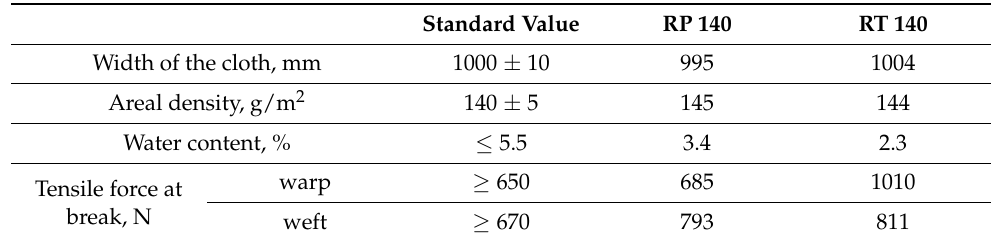
Table 3. It was obtained from Hunan Huashengdongting Ramie Co., Ltd. Yueyang, China. Table 3. Ramie fiber cloth used as natural reinforcing